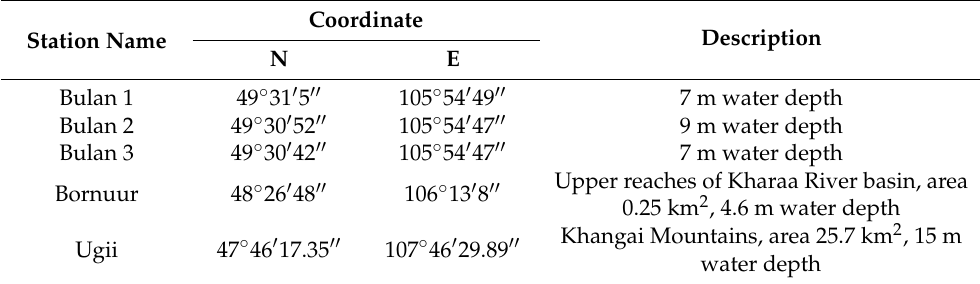
Table 1. Sampling sites and their locations in Lake Bulan, Lake Ugii, and Lake